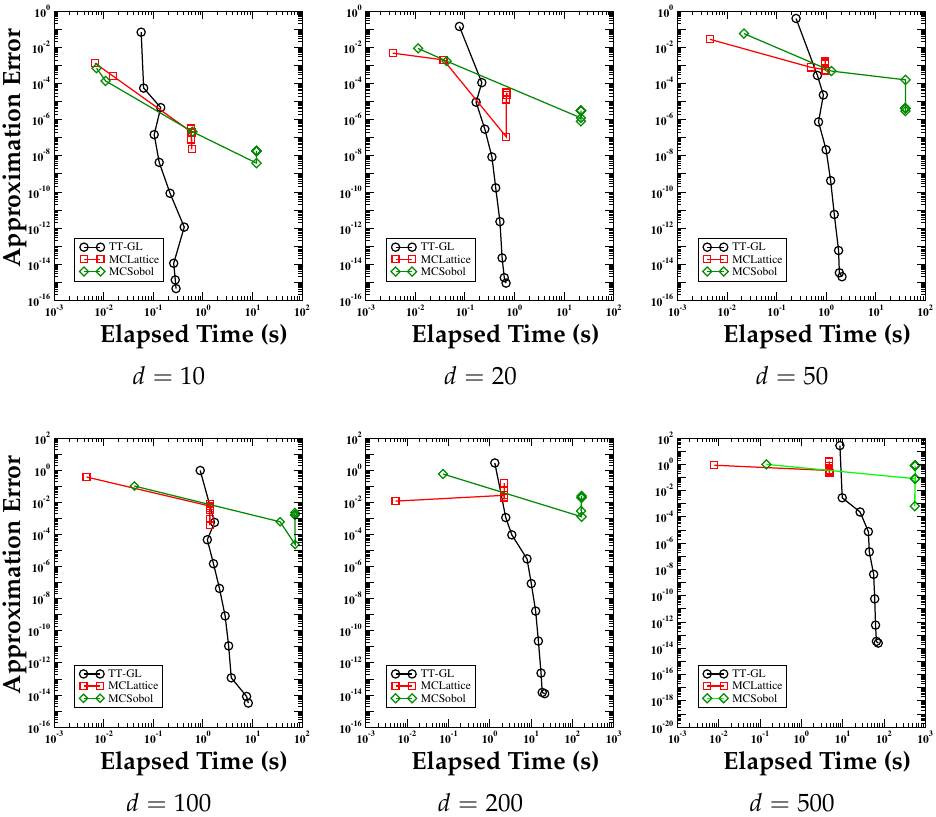
Figure 8. Test Case 7. Approximation error curves versus the elapsed time. We compare the performance of the strategy proposed in this paper and that of two Monte Carlo integration methods ( MC Lattice , MC Sobol ). The elapsed time is measured in seconds and the number of dimensions of the integrated function, d , is indicated below each panel. Each panel shows that our integration strategy is more efficient than the Monte Carlo